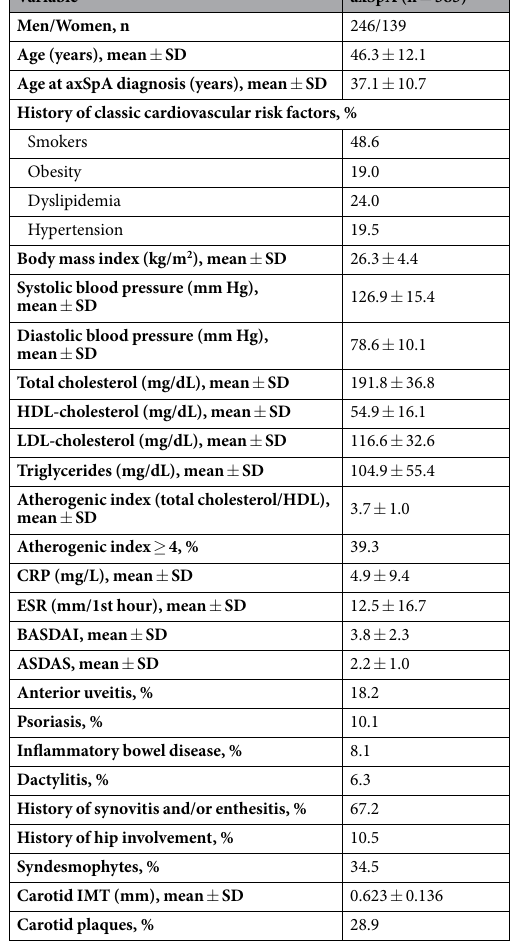
Table 1. Demographic, clinical, laboratory and cardiovascular disease-related data in patients with axSpA. ASDAS: Ankylosing Spondylitis Disease Activity Score; axSpA: Axial spondyloarthritis; BASDAI: Bath Ankylosing Spondylitis Disease Activity Index; CRP: C-Reactive Protein; ESR: Erythrocyte Sedimentation Rate; HDL: High-Density Lipoprotein; IMT: Intima-Media Thickness; LDL: Low-Density Lipoprotein; SD: Standard Deviation. Data shown in this table refer to values at the time of the